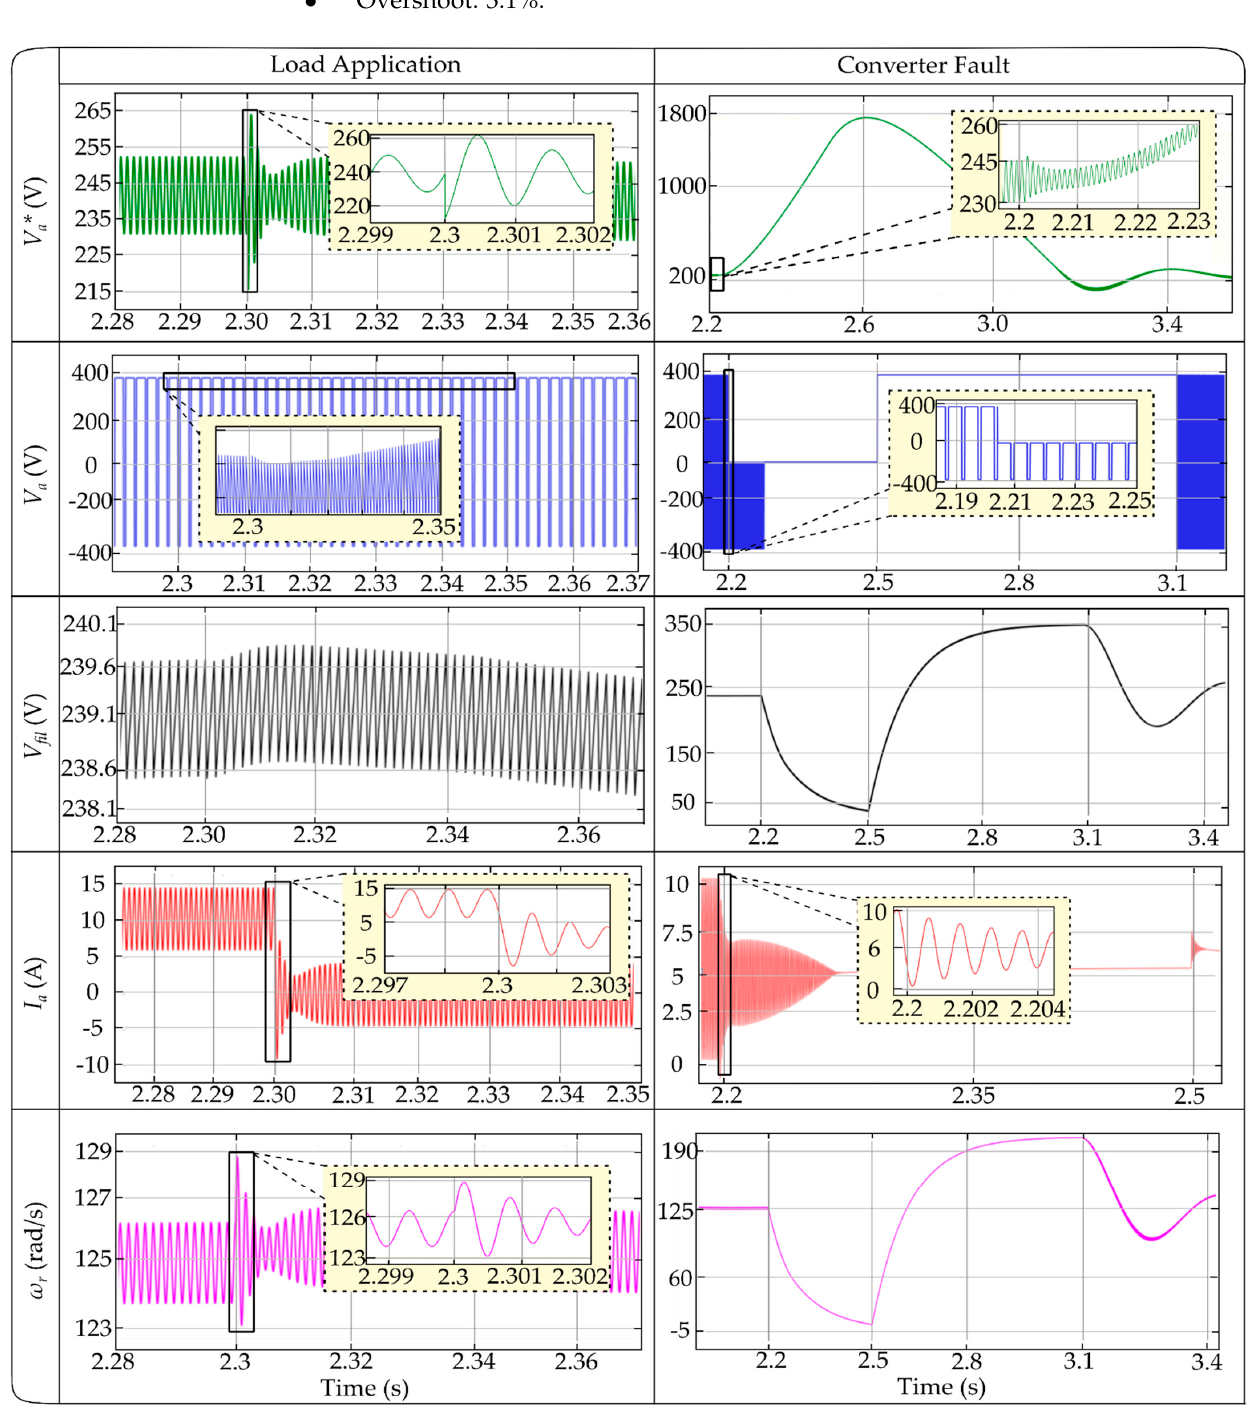
Figure 11. Test cases performed in an RT simulator.